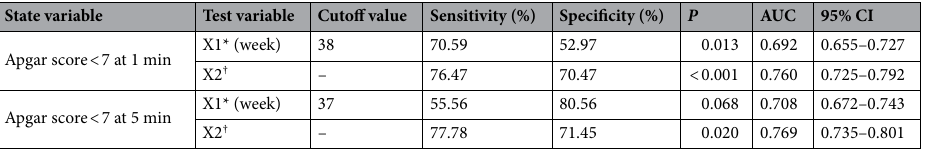
Table 6. The sensitivity and specificity of gestational age alone and its combination with fetal HbH disease in the prediction of an Apgar score < 7 at 1 or 5 min among thalassemic women. AUC, area under the curve. *Gestational age. † Fetus with HbH disease + Gestational age.